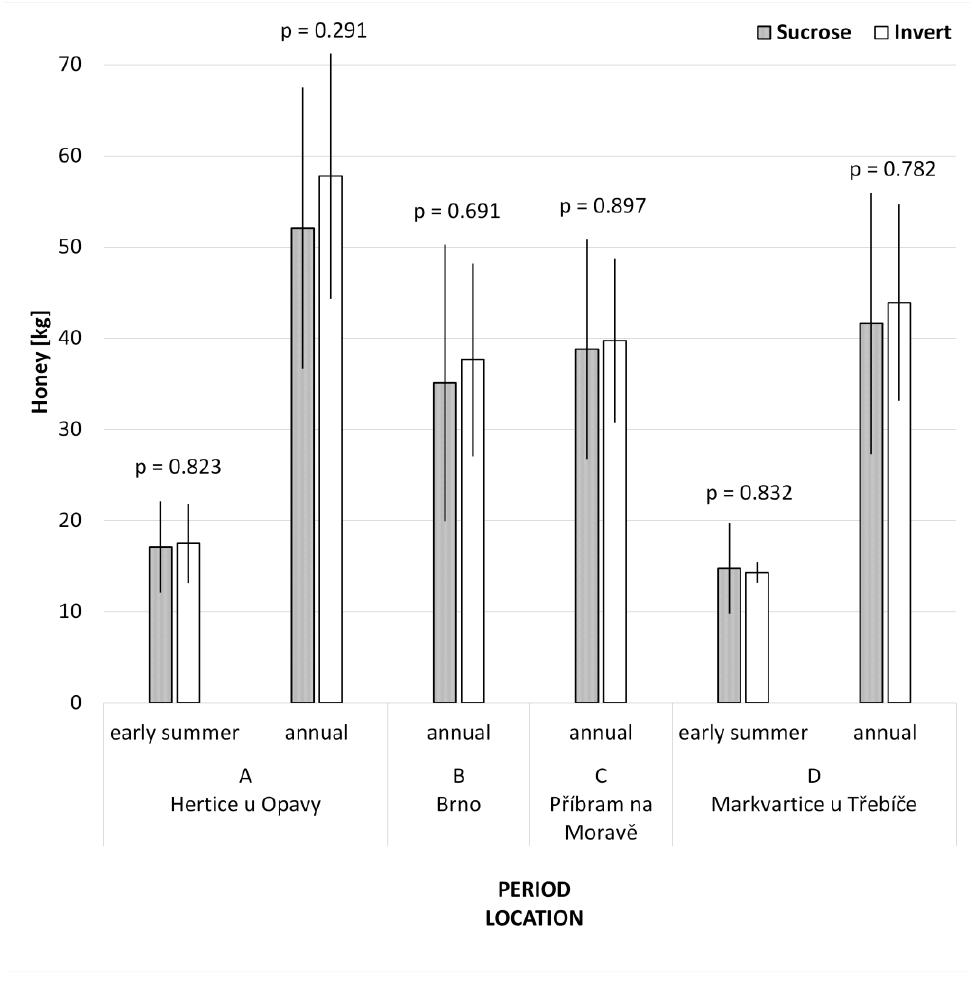
Figure 3. T Honey yield (mean ± SD) independent of the type of supplemental feed, sorted according to season and location. The differences are, from a production point of view, small and statistically insignificant ( p > 0.05, t -test); i.e., no effect of the invert syrup was